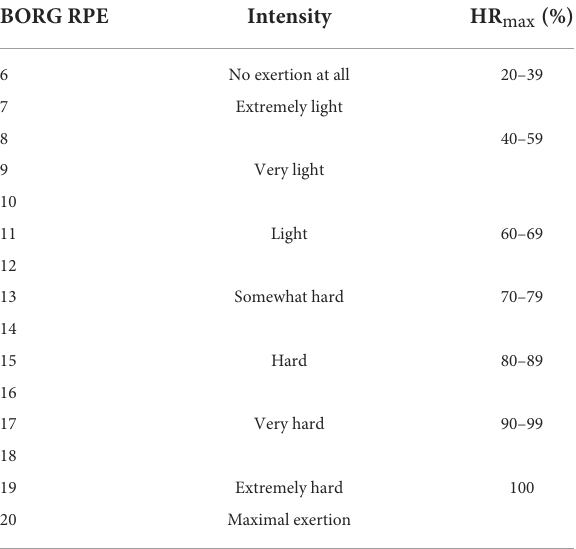
TABLE 1 Rating of Perceived Exertion (RPE) from 6-20 based on estimated heart rate [adapted from Borg (21)] (heart rate max, HRmax). BORG